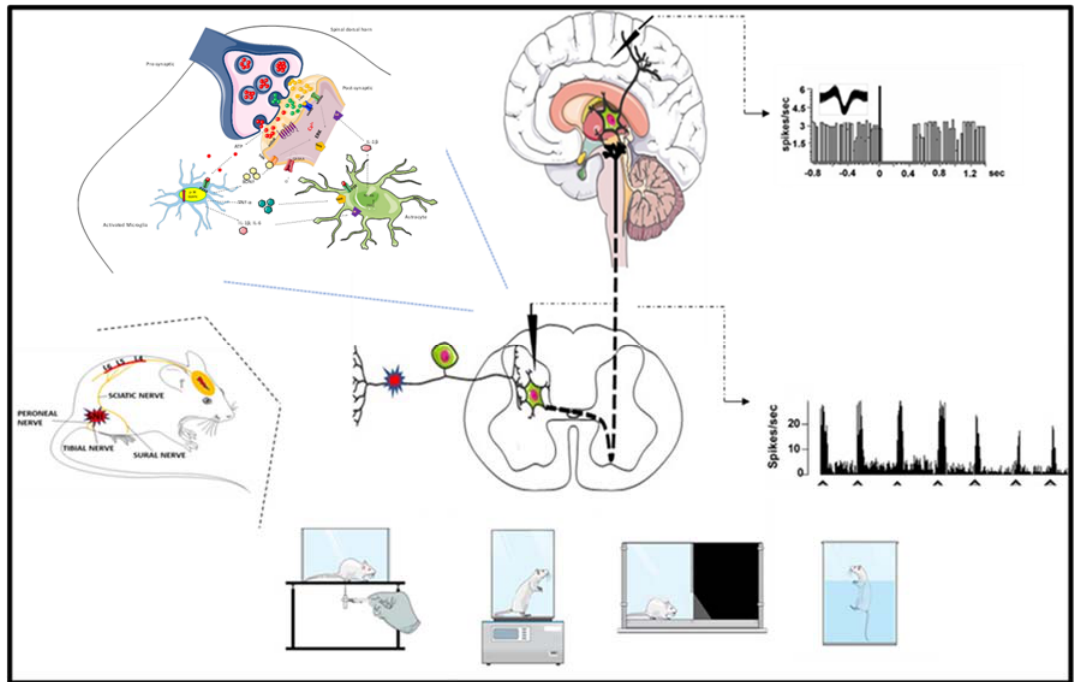
Figure 2. Summary scheme showing behavioral, biochemical and electrophysiological changes occurring after spared nerve injury (SNI).